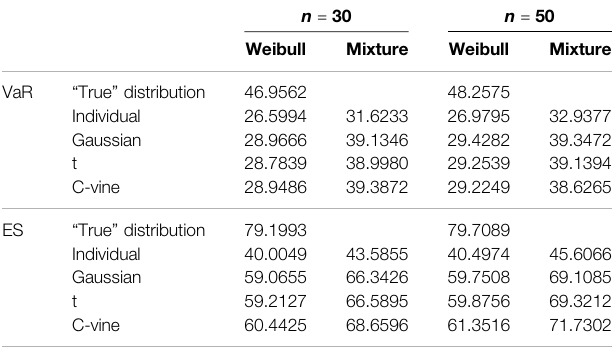
TABLE 10 | The average VaR and ES of aggregate losses for states in Group 1.